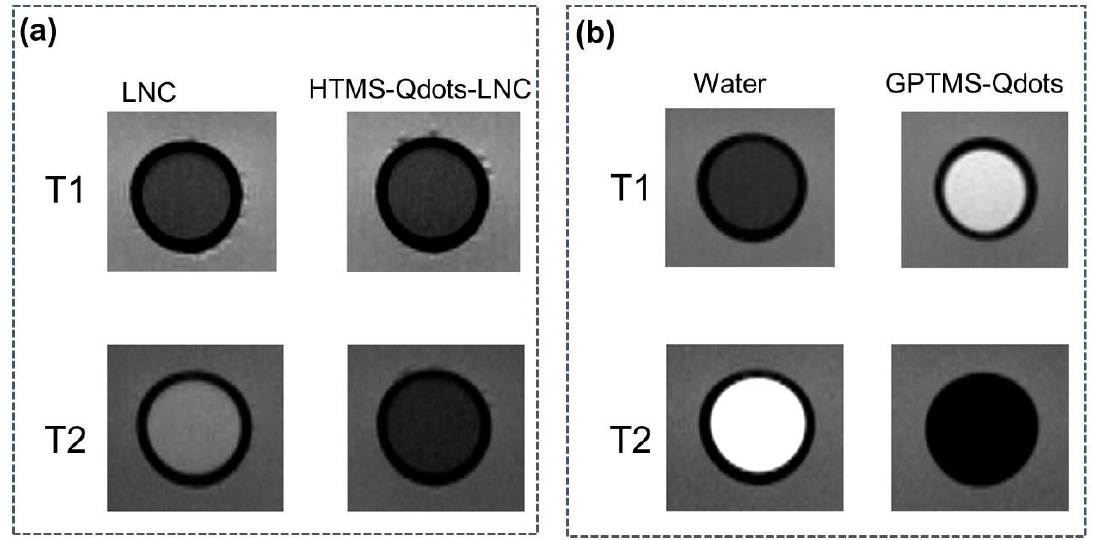
Figure 6. T1 and T2-weighted images of un-loaded LNC preparation and LNC loaded with HTMS-coated LNC ( a ). T1 and T2-weighted images of pure water and GPTMS-coated Qdots ( b ).